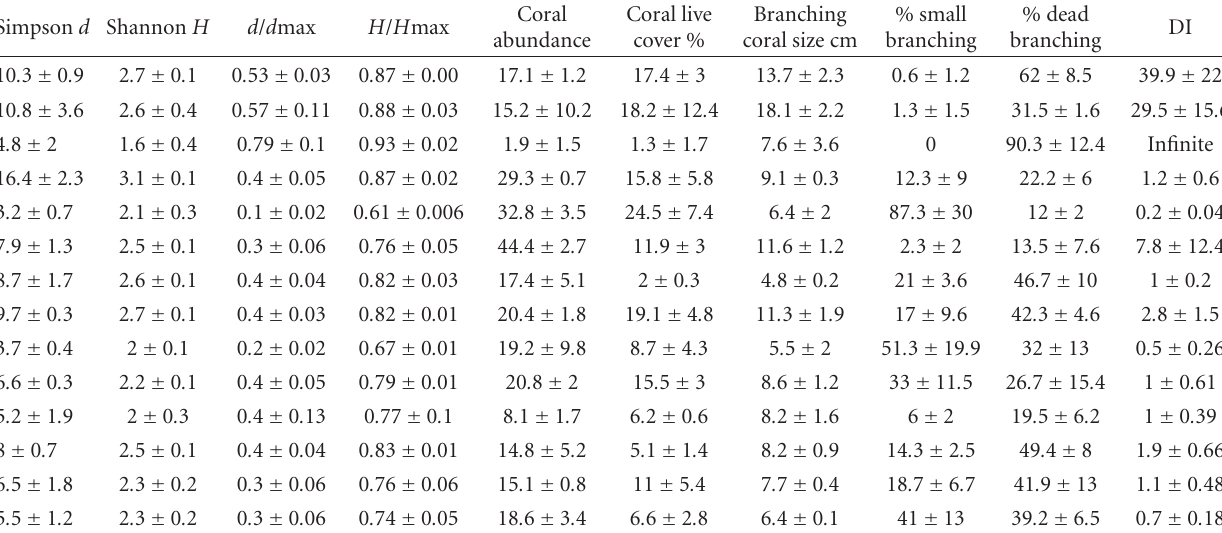
Table 3: Average values ( ± standard deviation) of ten indices obtained at the study stations of young coral communities. Stations are (from top to the bottom) Peace Lagoon, southern breakwater (P1); Peace Lagoon, end of southern breakwater (P2); Peace Lagoon, eastern breakwater (P3); Yacht marina, south side of breakwater (Y1); Yacht marina, east side of breakwater (Y2); Naval port (N1); Dekel beach, plain (D1). Dekel beach, slope (D2); Dekel beach, large rocks (D3); Dolphin Reef (E2); Tur-Yam (T1); Lighthouse beach, small size rocks (L1); Lighthouse beach, large size rock (L3); Lighthouse beach, southern slope